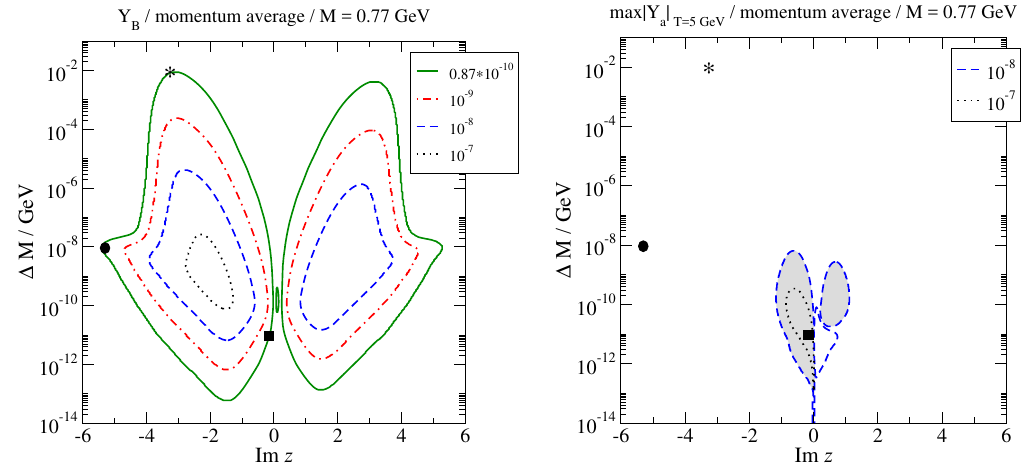
Figure 1 . Left: contours of the total baryon yield Y in the plane of Im z and (cid:1) M , with other B parameters (cid:12)xed according to eqs. (7.1) and (7.2). The smallest value considered is Y = 0 : 87(1) (cid:2) B 10 (cid:0) 10 [54]. Two benchmarks ((cid:12)lled circle and square) are studied in more detail in sections 8 and 9, respectively, whereas the point indicated with a star was studied in ref. [26]. Right: analogous results for the maximal lepton asymmetry max fj Y jg , evaluated at T = 5 GeV. Within the shaded a domains Y ; Y are negative, within the unshaded a B